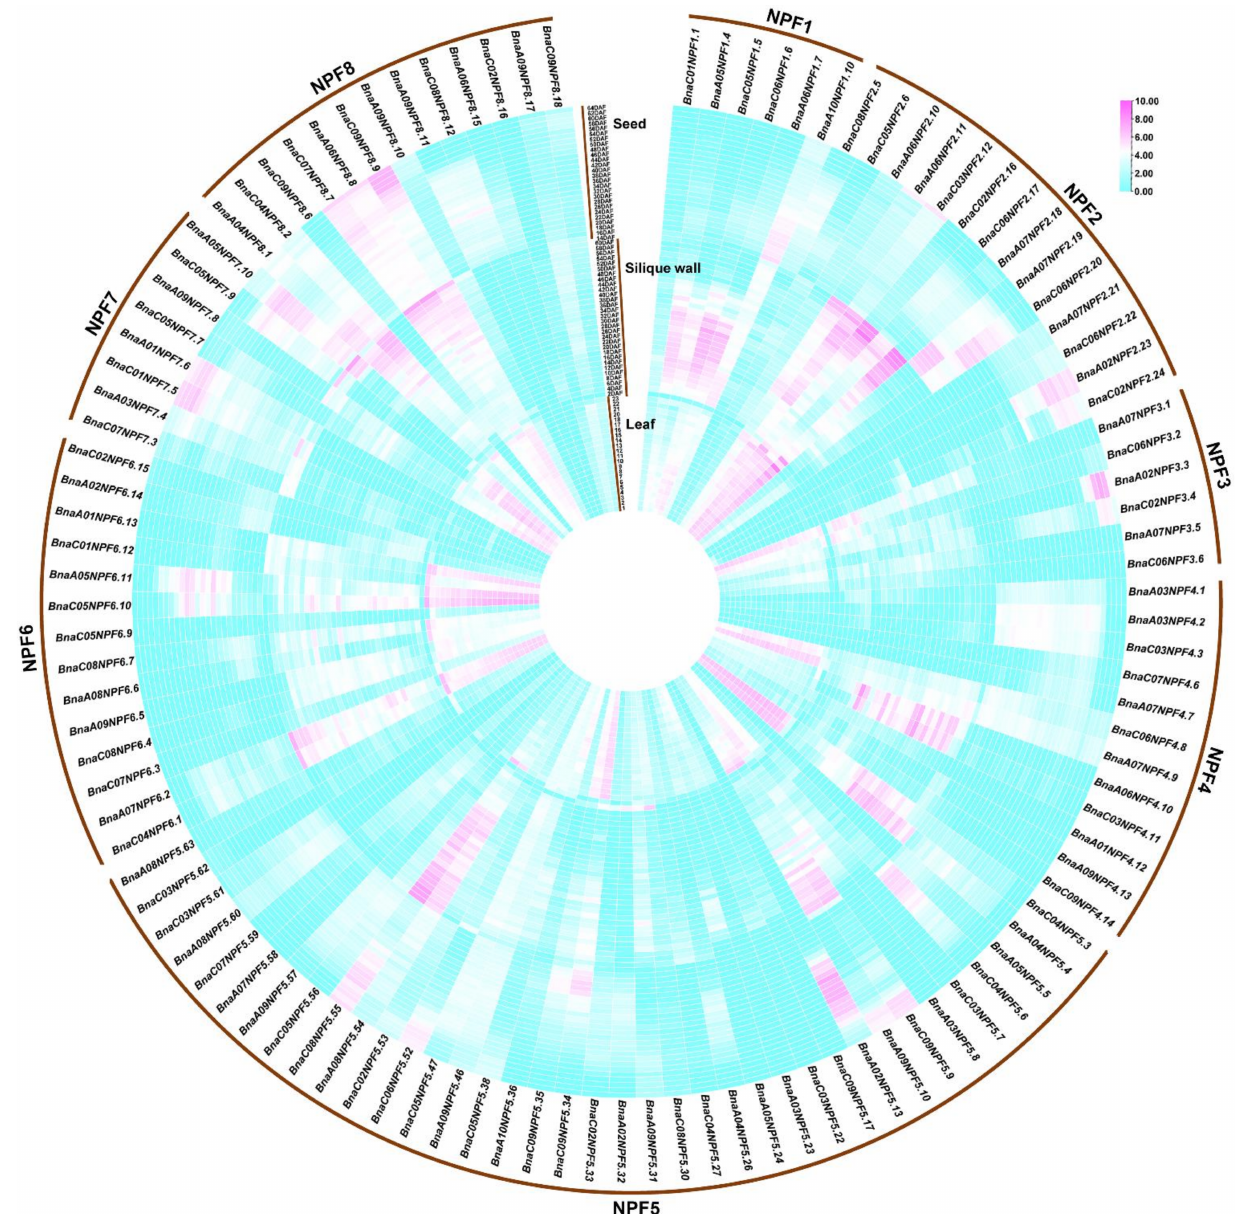
Figure 4. Expression changes of the BnaNPF genes at different development stages of leaves, silique wall and seeds. FPKM values were processed with log2 normalization on the column scale. The color scale represents relative expression levels from high (purple) to low